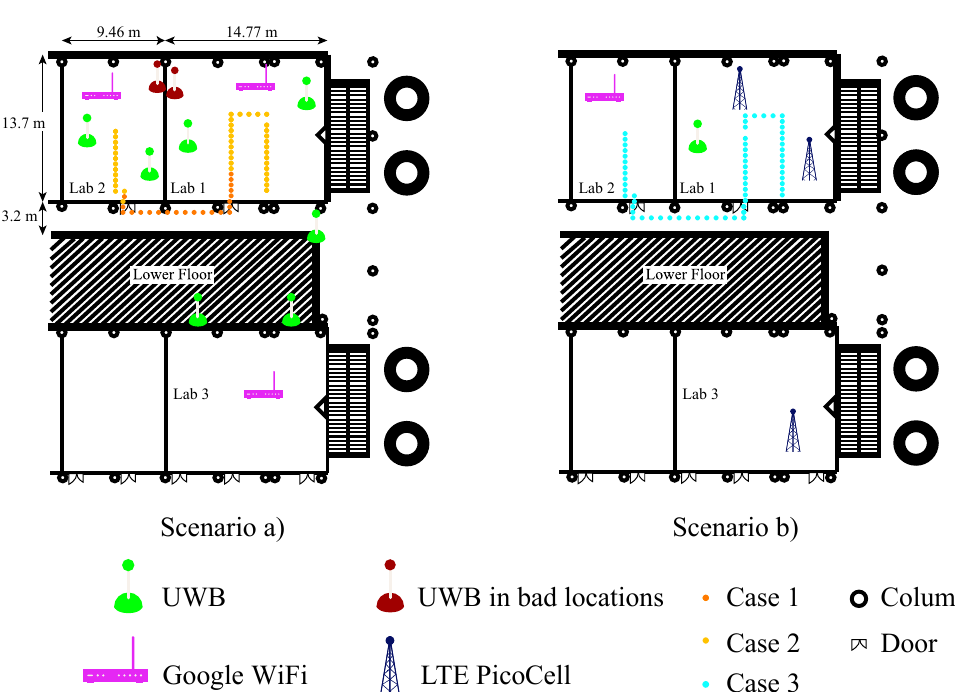
Figure 3. High density ( a ) and low density ( b ) scenario set-up